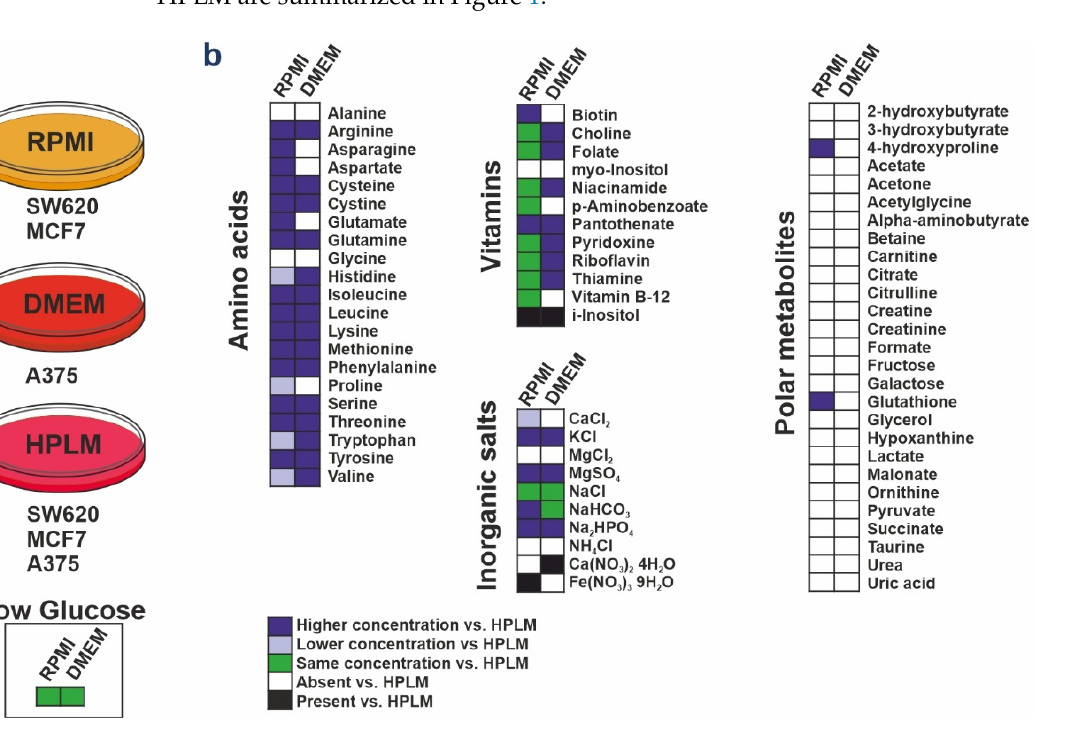
Figure 1. Media formulation of RPMI, DMEM, and HPLM. ( a ) All experiments were performed in these media supplemented by 10% dialyzed FBS. Glucose concentration of DMEM and RPMI was modified as physiological concentration (low glucose, 5 mM). ( b ) The chart shows the relative con- centrations of RPMI and DMEM media supplemented with 5 mM glucose compared with HPLM. Components not present in RPMI and DMEM but present in HPLM are denoted as “absent”; com- ponents not present in the HPLM but present in the other media are denoted as “present”. First, we tracked cell proliferation kinetics in terms of confluence as a function of time and the proliferation rates as the area under the curve AUC. The linear regressions of these data sets highlight differences of growth curves for two cell lines. The proliferation rate in SW620 cells cultured in HPLM +FBS was decreased, starting at 40 h and causing a difference of 29.5 h. This led to a strong delay of SW620 growth in HPLM +FBS (Figure 2a–c). Differ- ences in MCF7 proliferation were undetectable (Figure 2d–f). In contrast, the proliferation rates were augmented in the melanoma cell line A375 in the presence of HPLM +FBS (Figure 2g–i). Taken together, HPLM supported the growth of all three cell lines. However, HPLM +FBS surprisingly exerted opposite effects on cancer cell proliferation of SW620 and A375 cell lines.